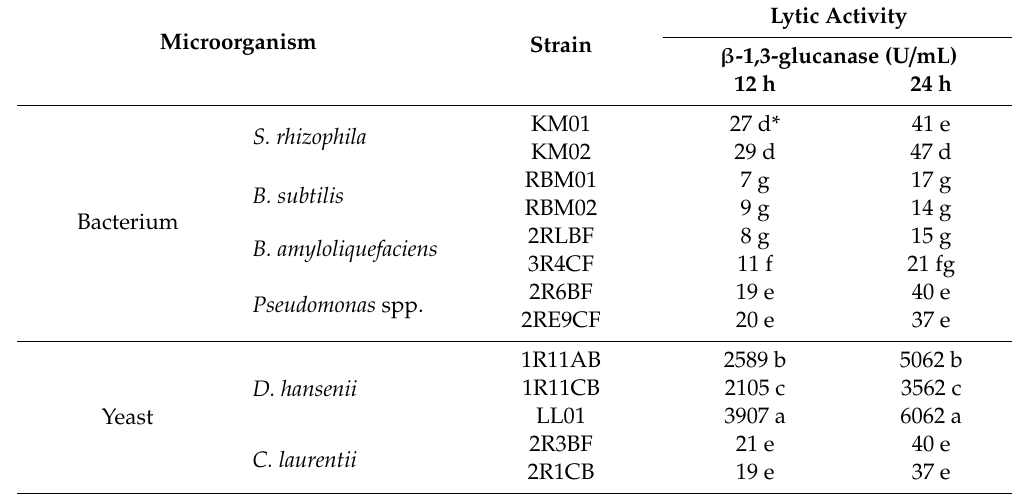
* The values are the means ± standard deviation (SD) of 10 replicates. Different letters indicate a significant difference ( p < 0.05) according to Tukey’s test.